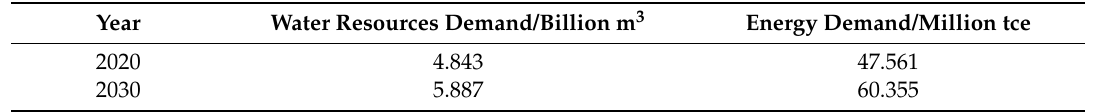
Table 2. ANN Forecast of the water-energy demand for